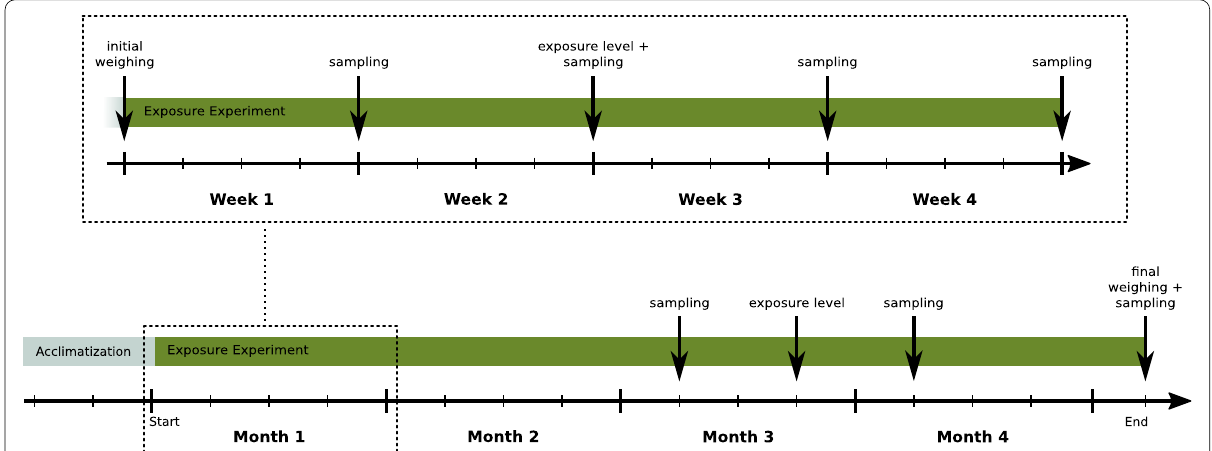
Fig. 2 Overview of the sampling scheme in the exposure experiment (additional weighing of all experimental fish was conducted at the beginning and the end of the